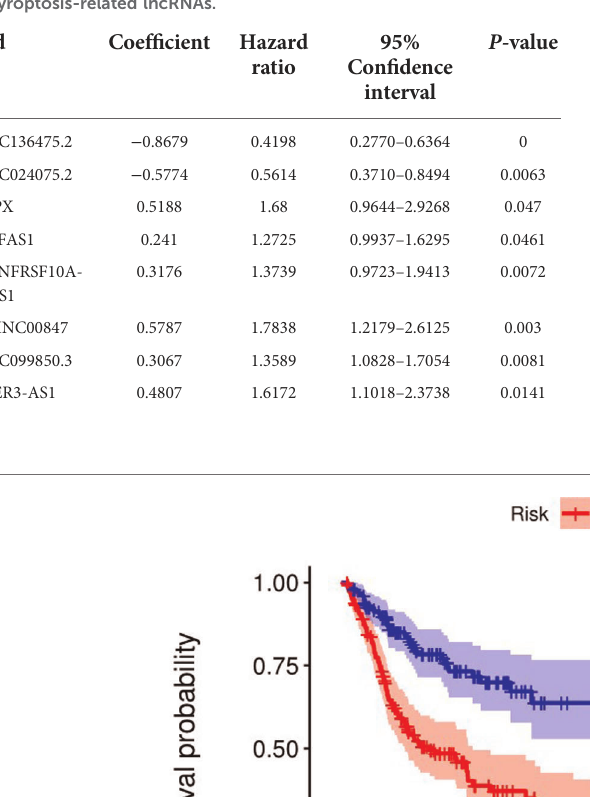
TABLE 2 The LASSO Cox proportional hazard model of the 8 pyroptosis-related lncRNAs.